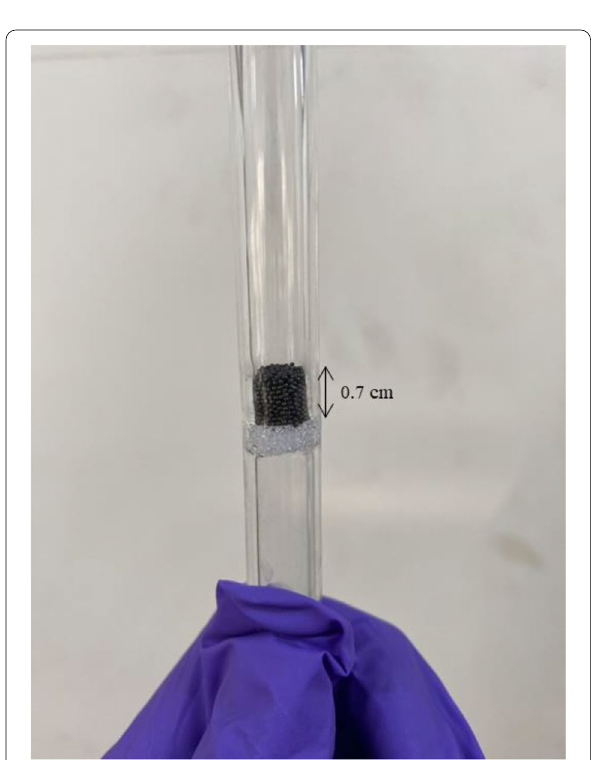
Fig. 2 Photo of KBAC sample packed in the glass fixed